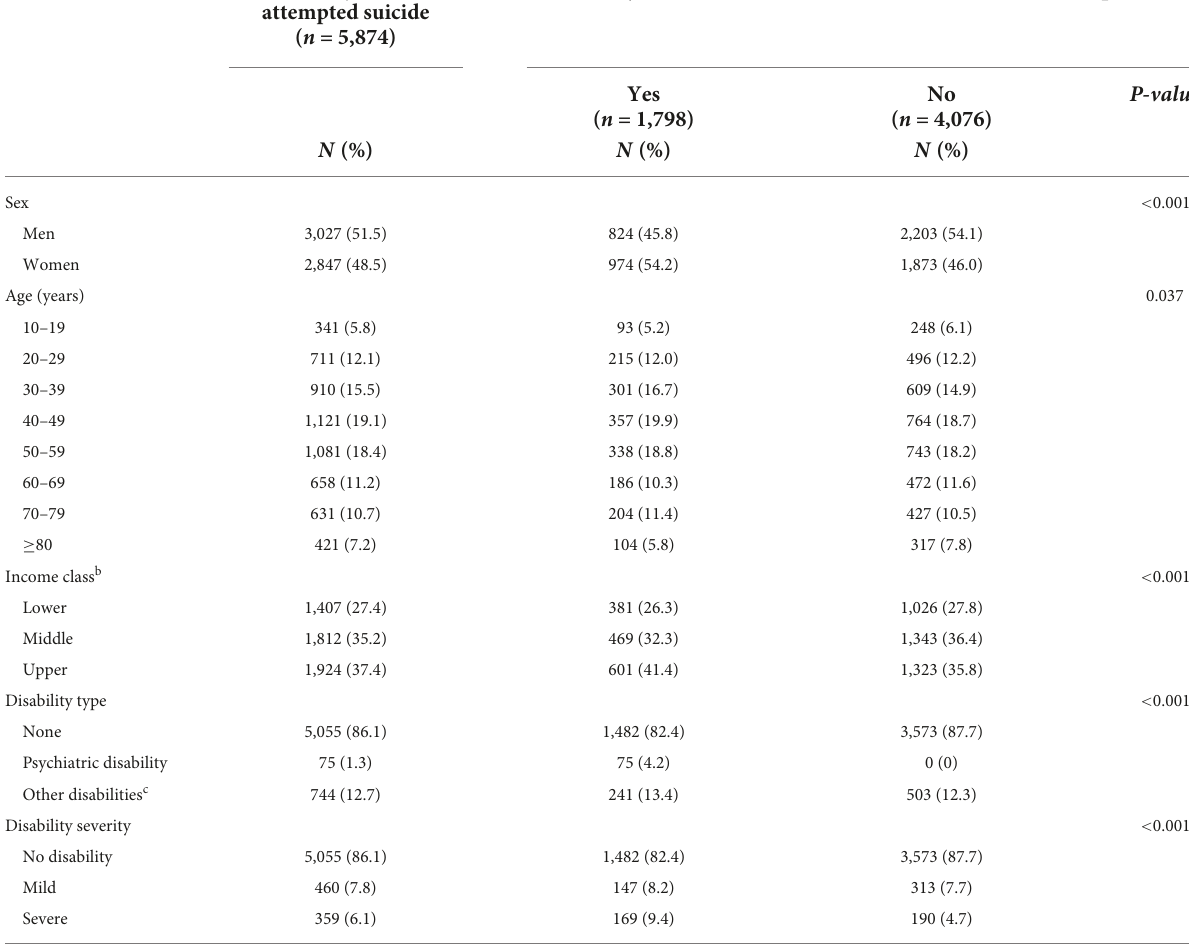
TABLE 1 Demographic and socioeconomic characteristics of the study